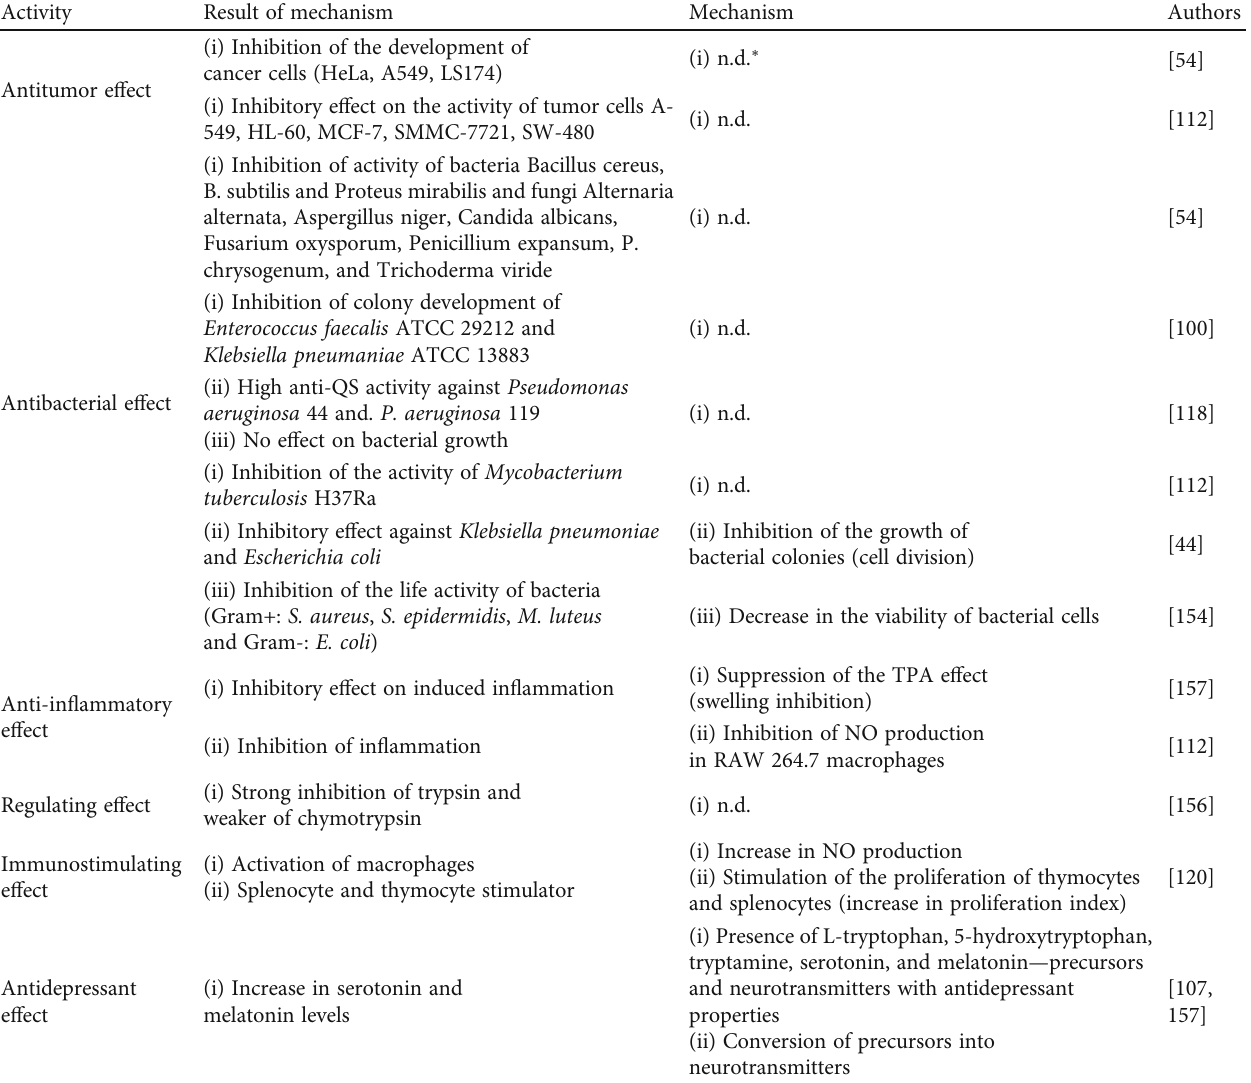
Table 5: Action mechanisms by bioactive substances contained in Macrolepiota procera , other than antioxidant (from 2015 to 2021). Activity Result of